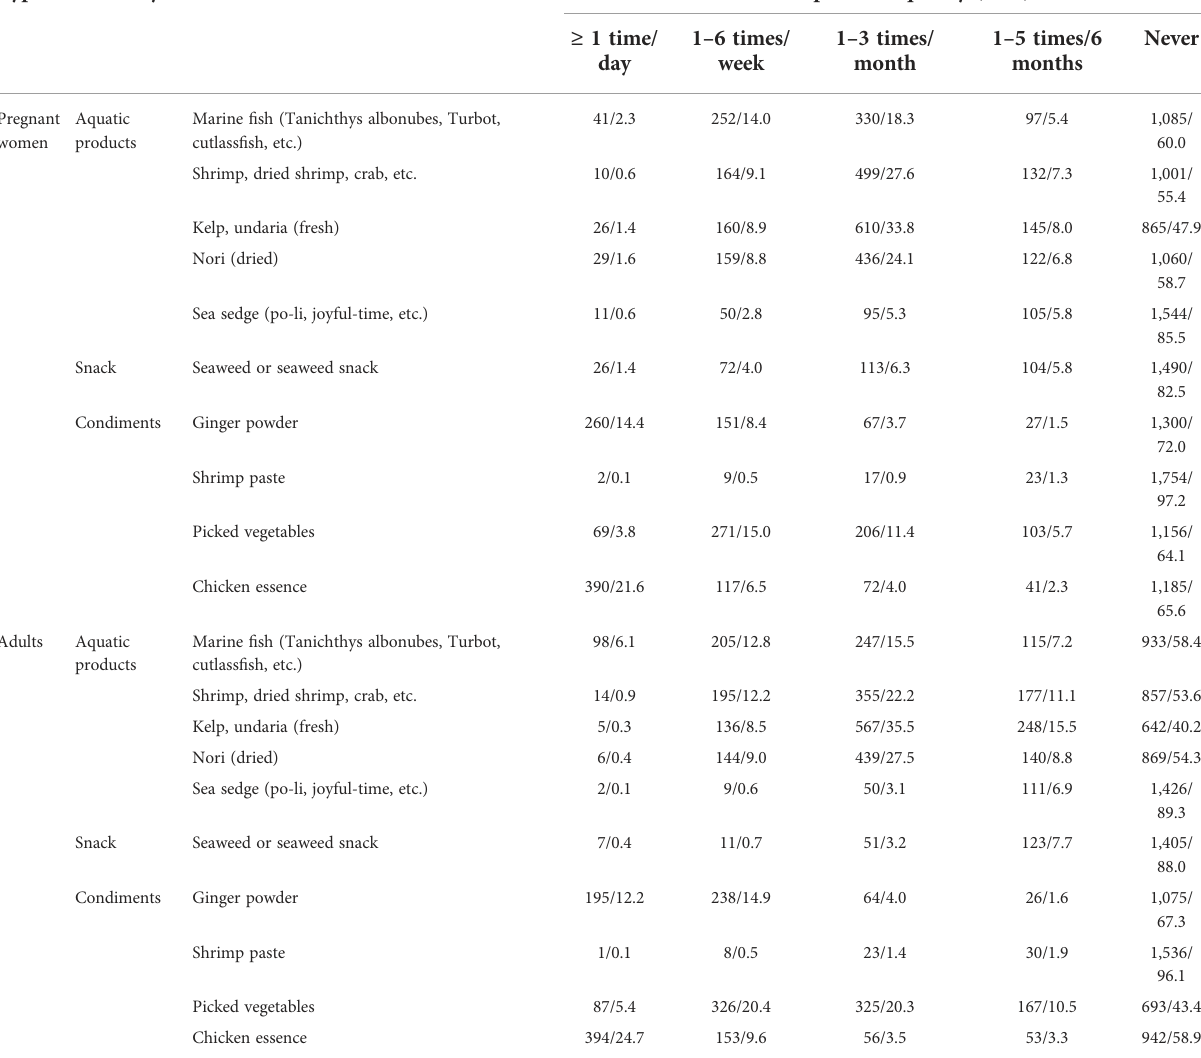
TABLE 6 The consumption frequency of food (iodine contain ≥ 100 m g/100